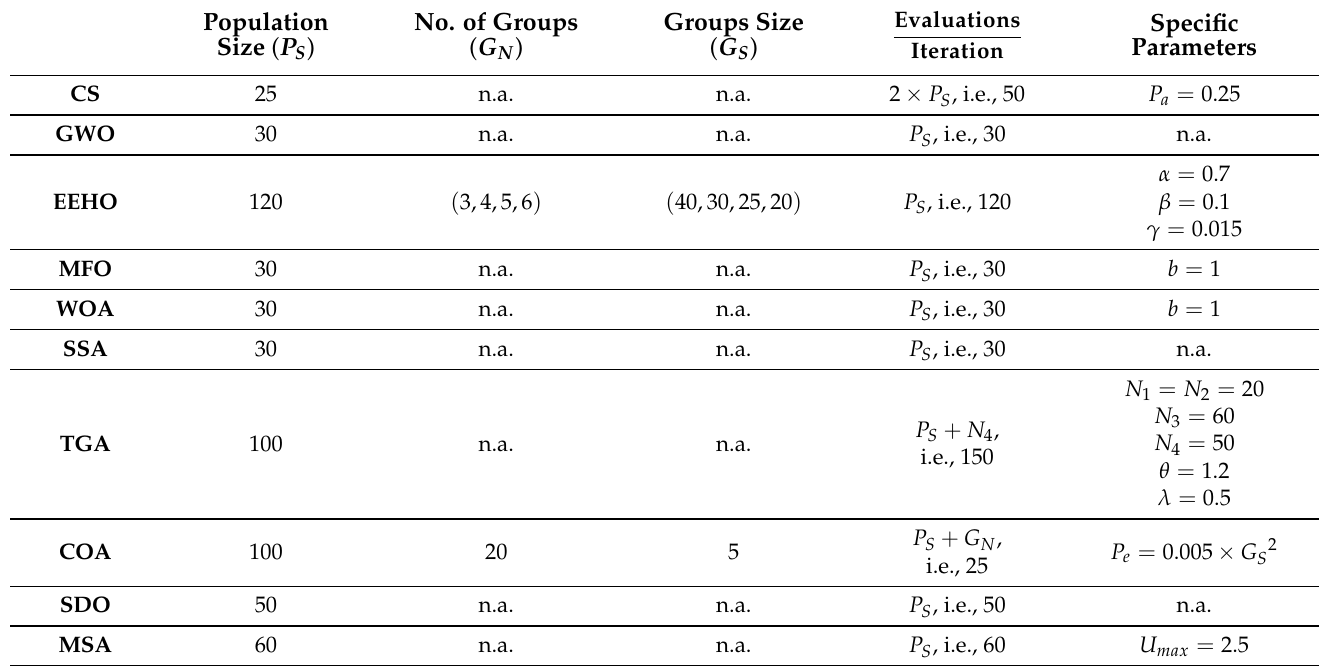
Table 6. Algorithms’